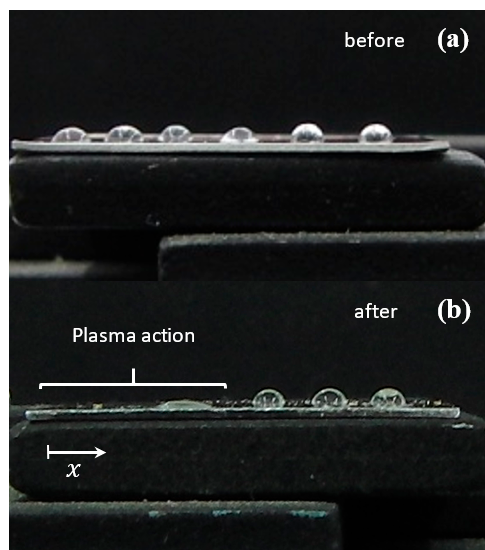
Figure 2. Photographs of water drops deposited in an aluminum sample before ( a ) and after the treatment ( b ) (1% N 2 in Ar-N 2 , 150 W).